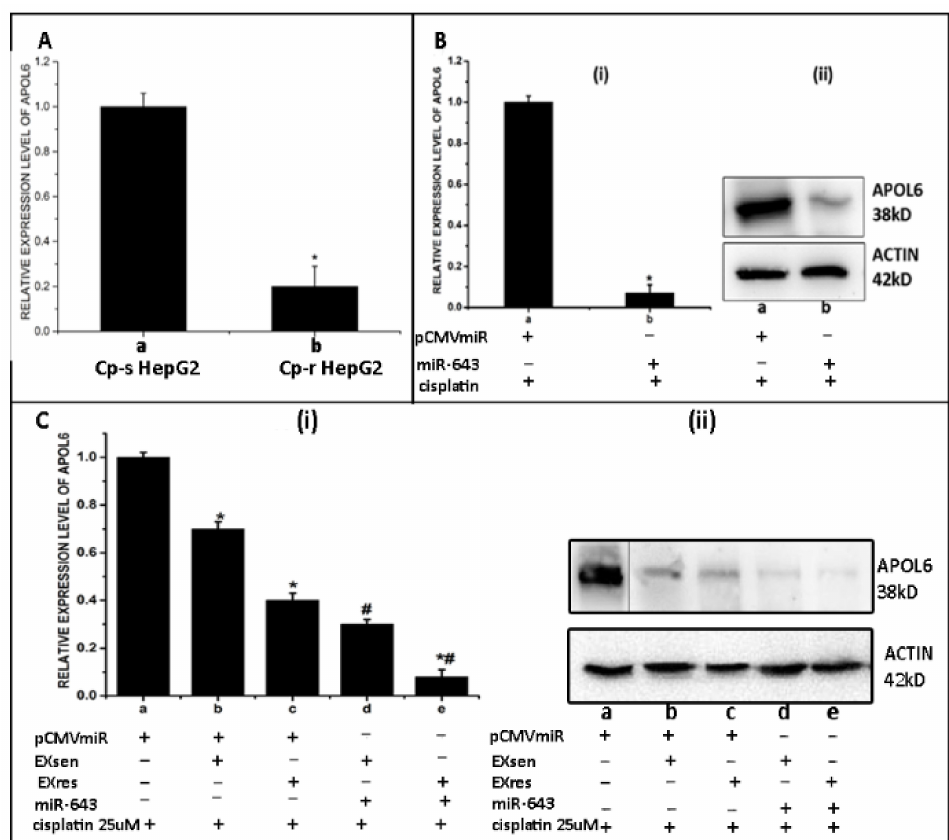
Figure 6. Ectopic expression of miR-643 can reduce APOL6 levels and augment the effect of EXres on APOL6 levels. ( A ) Expression level of APOL6 in Cp-r HepG2 cells. RNA was isolated from Cp-s and Cp-r HepG2 cells followed by cDNA synthesis and RT-PCR analysis of APOL6. In A, a represents Cp-s HepG2 cells and b represents Cp-r HepG2 cells. ( B ) APOL6 mRNA and protein levels under miR-643 overexpression condition. Hela cells were transfected with pCMVmiR (control) or miR-643 construct. 48 h post transfection, protein and RNA was isolated to estimate APOL6 expression levels by real-time PCR ( i ) and protein levels were analysed by Western blot analysis ( ii ). In ( B ), a—vector alone transfected cells + cisplatin (25 µ M) and b—miR-643 overexpressed cells + cisplatin (25 µ M). Results presented are the average of two experiments ± SEM each done at least in triplicate, p < 0.05. * Statistically significant when compared to a. ( C ) Ectopic expression of miR-643 augments the effect of EXres on APOL6 levels. miR-643 overexpressing Hela cells were treated with EXsen/EXres followed by analysis of APOL6 mRNA and protein levels. ( i ) APOL6 mRNA levels analysed by RT-PCR. ( ii ) APOL6 protein levels analysed by Western blot. In ( i , ii ) a—vector only transfected cells + cisplatin, b—vector only transfected cells + cisplatin and EXsen, c—vector only transfected cells + cisplatin and EXres, d—miR-643 overexpressing cells + cisplatin and EXsen and e—miR-643 overexpressing cells + cisplatin and EXres. The mean values of two different experiments ± SEM each performed in triplicate are reported in the graph, p < 0.05. * indicates statistical significance when compared to a and b. # indicates statistical significance when compared to b. *# indicates statistical significance when compared to c. Two irrelevant lanes were spliced out from the blot C ( ii ) of APOL6 and full-length blots are given in Figure